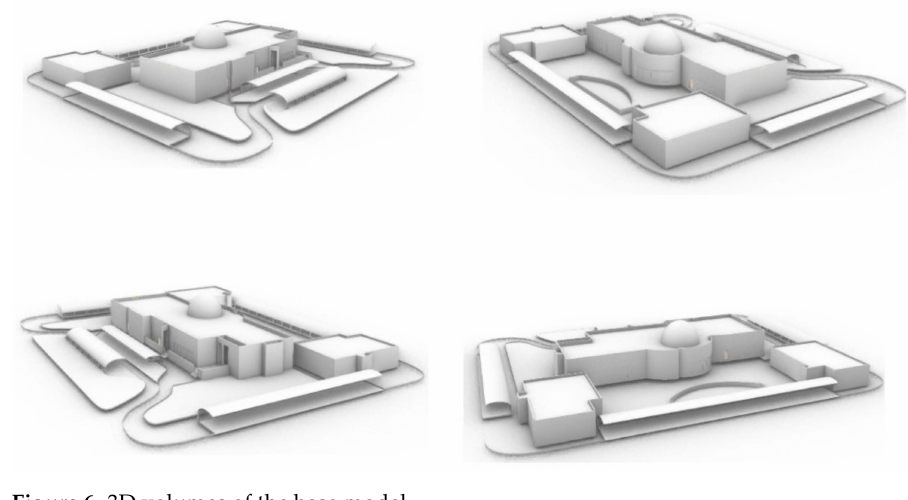
Figure 6. 3D volumes of the base model.